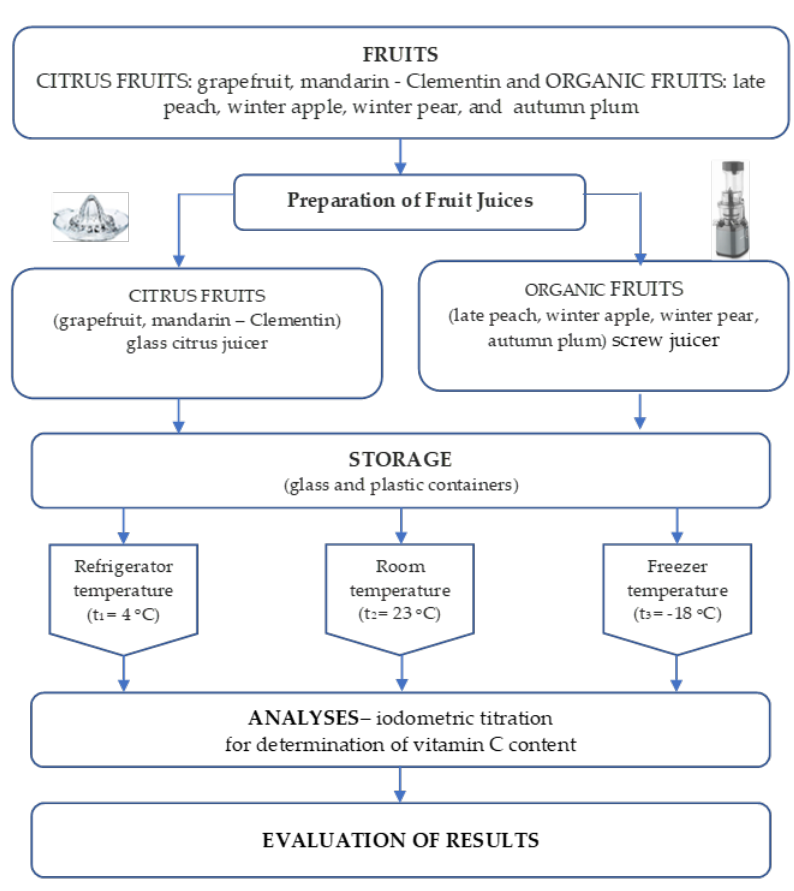
Figure 2. Scheme of unit operation for the preparation of fruit juices.